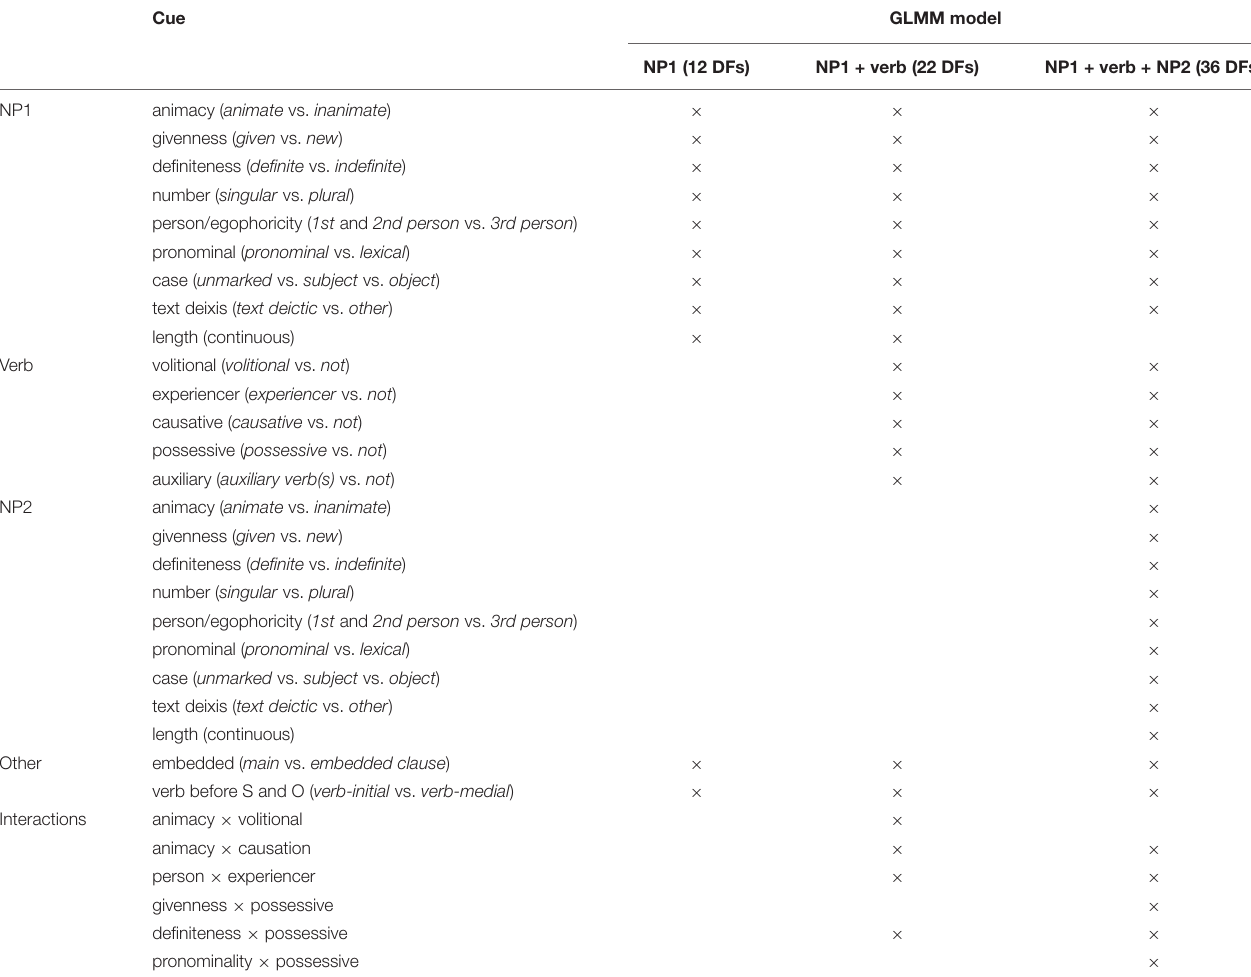
TABLE 1 | All linguistic cues used to predict OS vs. SO order at four different points in the sentence through separate Bayesian mixed-effects regressions (GLMMs). Cue GLMM model NP1 (12 DFs) NP1 + verb (22 DFs) NP1 + verb + NP2 (36 DFs) NP1 animacy ( animate vs. inanimate ) × × × givenness ( given vs. new ) × × × definiteness ( definite vs. indefinite ) × × × number ( singular vs. plural ) × × × person/egophoricity ( 1st and 2nd person vs. 3rd person ) pronominal ( pronominal vs. lexical )